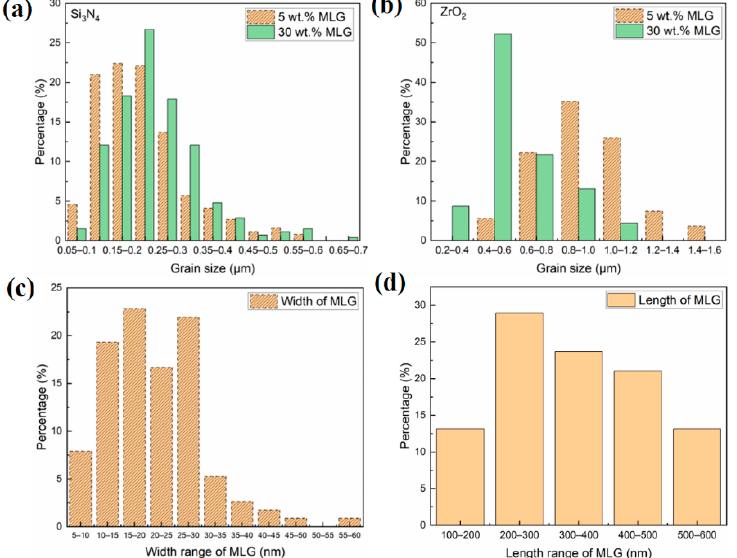
Figure 4. Histograms of size distribution for Si 3 N 4 ( a ), ZrO 2 ( b ), and MLG ( c , d ) in the sintered composites with different graphene content, analyzed from SEM and TEM images.